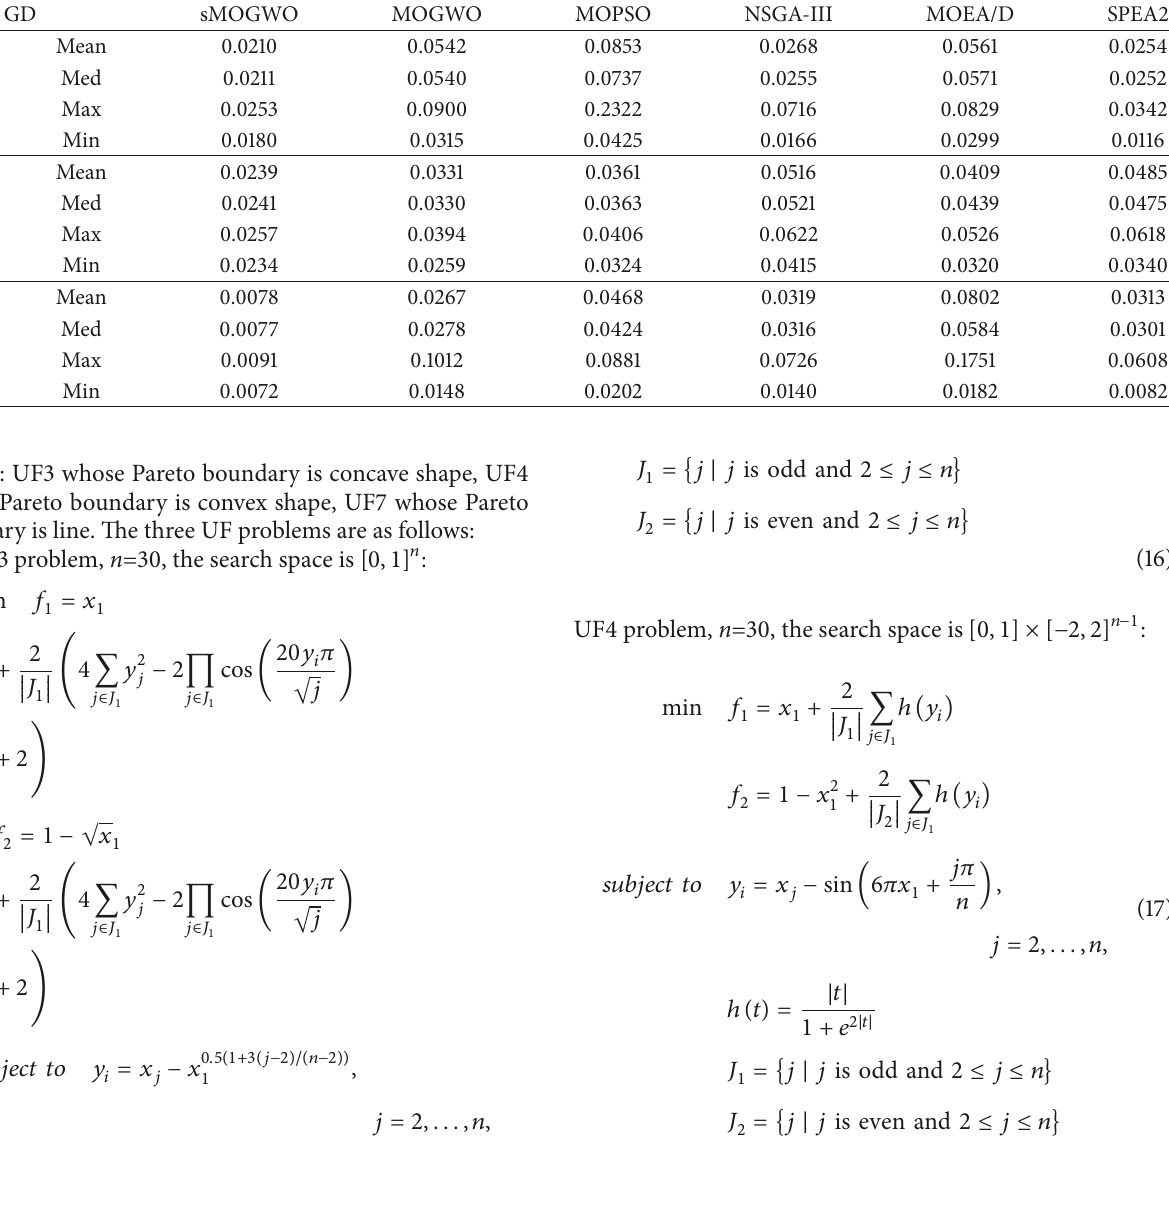
Table 2: Statistical results of GD for different